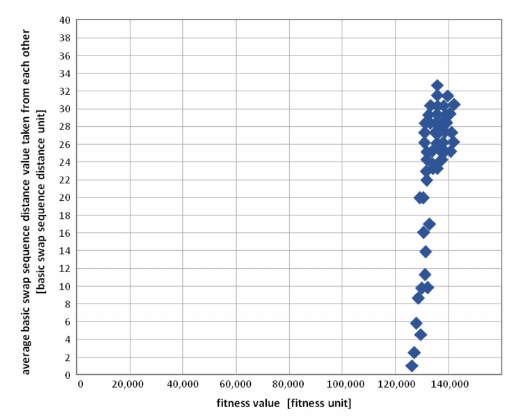
Figure 11. The basic swap sequence distances from the best of the solutions in case of 2-opt